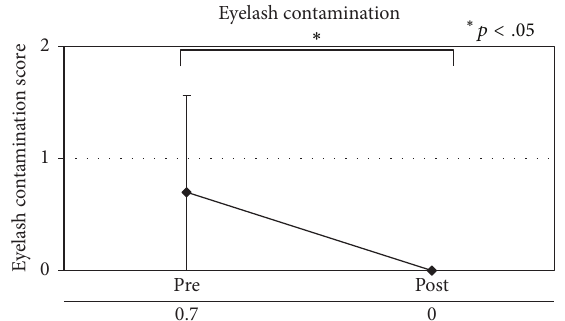
Figure 4: Eyelash contamination in patients with meibomian gland dysfunction.